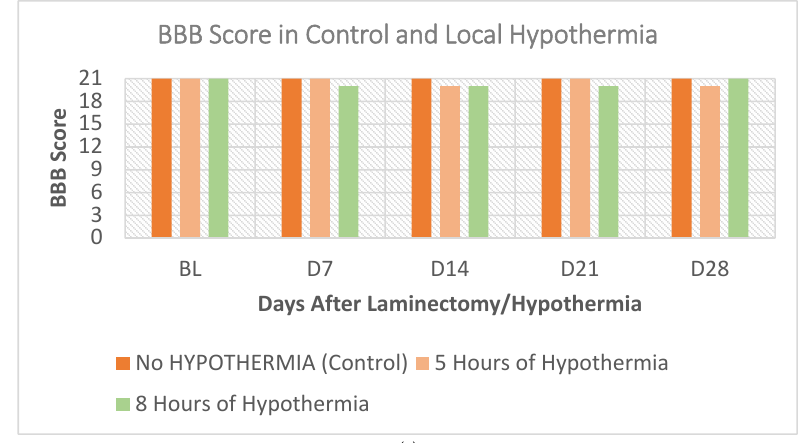
Figure 1. shows that prolonged local hypothermia is not harmful ( n = 15). The three plots show SSEP signals of the left hindlimbs ( a ) and the right hindlimbs ( b ) as well as the average BBB scores ( c ) of rats in normothermia, 5 h, and 8 h local hypothermia groups.